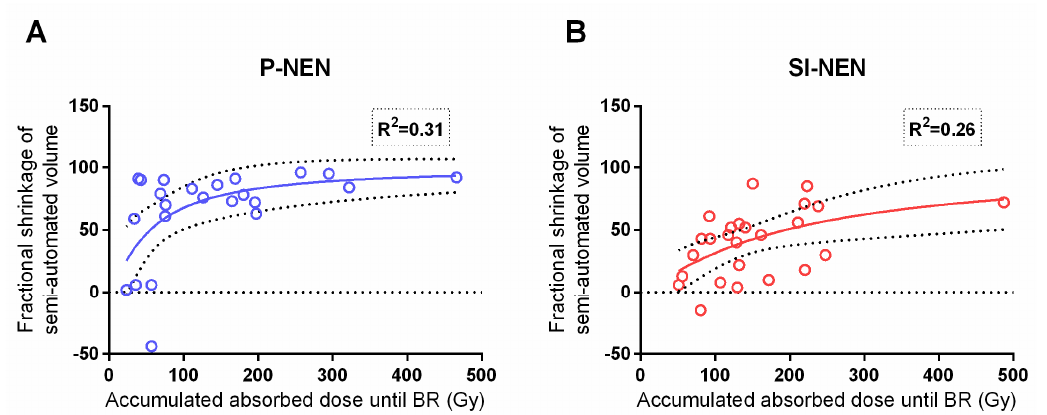
Figure 6. Comparison between tumor dose (Gy) and diameter shrinkage in P-NENs versus SI-NENs. Accumulated absorbed dose (Gy) to the tumor versus maximum fractional diameter shrinkage in P-NEN lesions ( A ) ( n = 23) and SI-NEN lesions ( B ) ( n = 24). P-NEN ( p = 0.004), SI-NEN ( p = 0.001). BL; baseline.